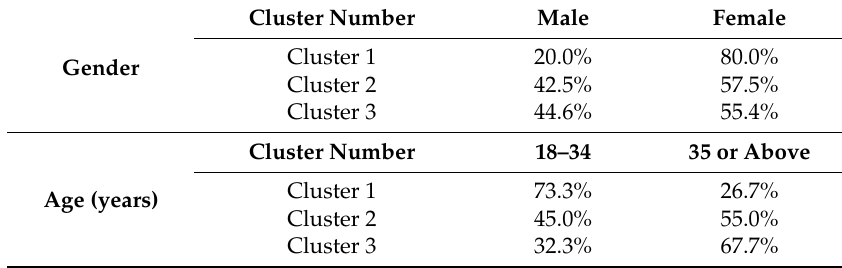
Table 5. Summary of demographics from the overall liking clusters (percentage of consumers). Cluster Number Gender